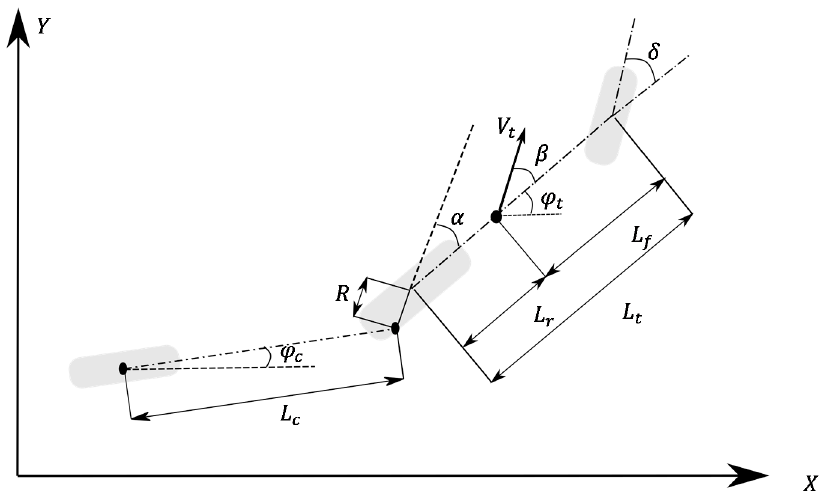
Figure 2 . Kinematic bicycle model of the tractor-cart system. Figure 2. Kinematic bicycle model of the tractor-cart